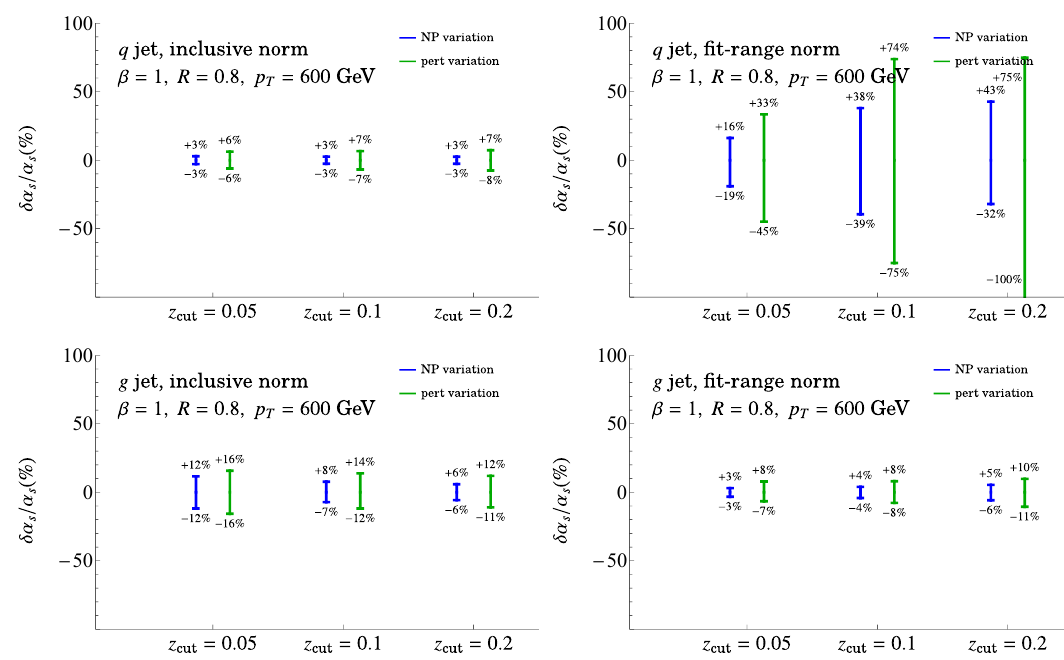
Figure 14 . Uncertainty in α s ( m Z ) due to profile variations and nonperturbative-parameter uncer- tainty, for different values of z , for the normalized soft-drop jet-mass cross section. cut